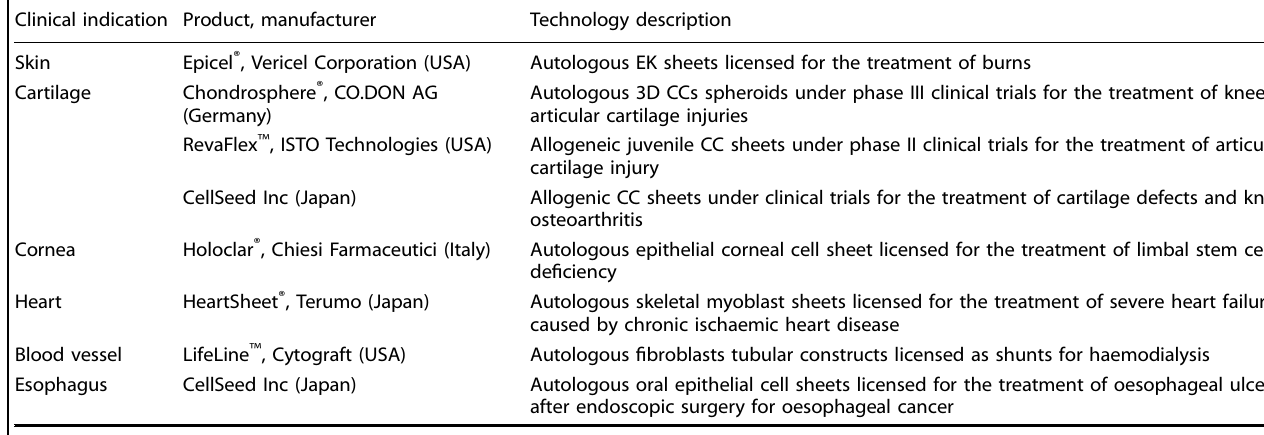
Table 2. Commercially available scaffold-free cell systems. Clinical indication Product, manufacturer Technology description